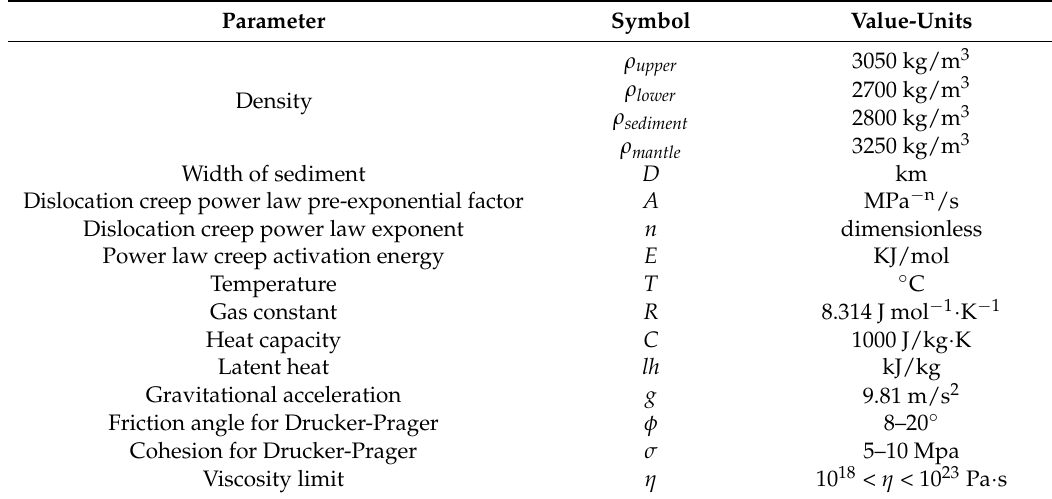
Table 4. Parameters used in